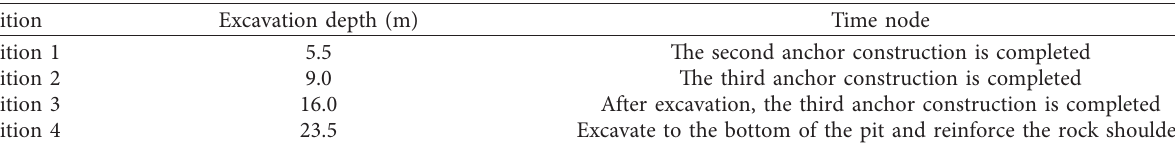
Table 5: Parameters of prestressed anchor cable.